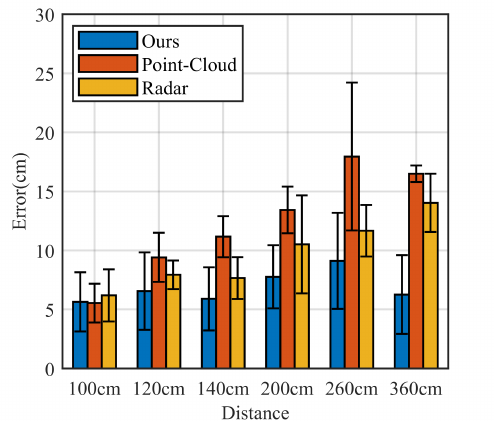
Figure 16. Comparison results of the three positioning